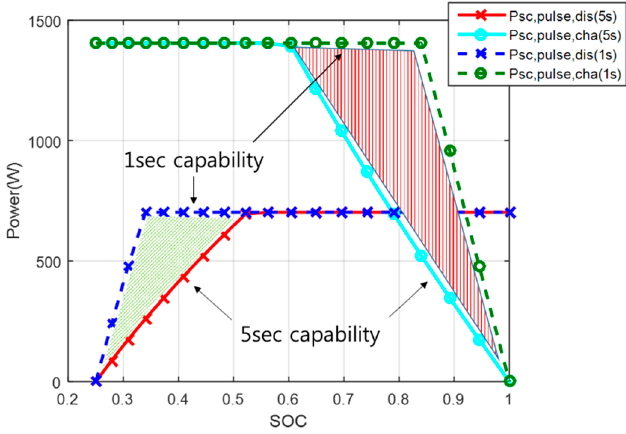
Figure 14. Supercapacitor pulse power capability for 1 second and 5 seconds.